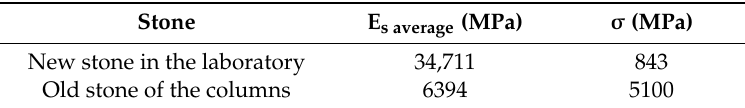
Table 2. Impact tests on new and old granitic stones.